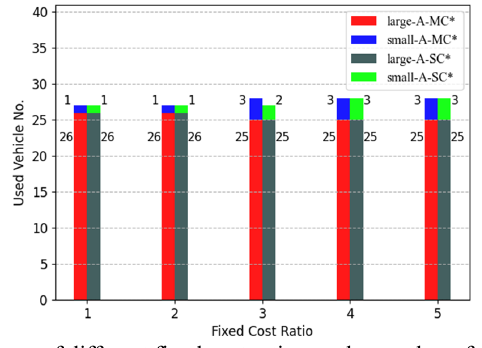
Fig. 6. Influence of different fixed cost ratios on the number of vehicles